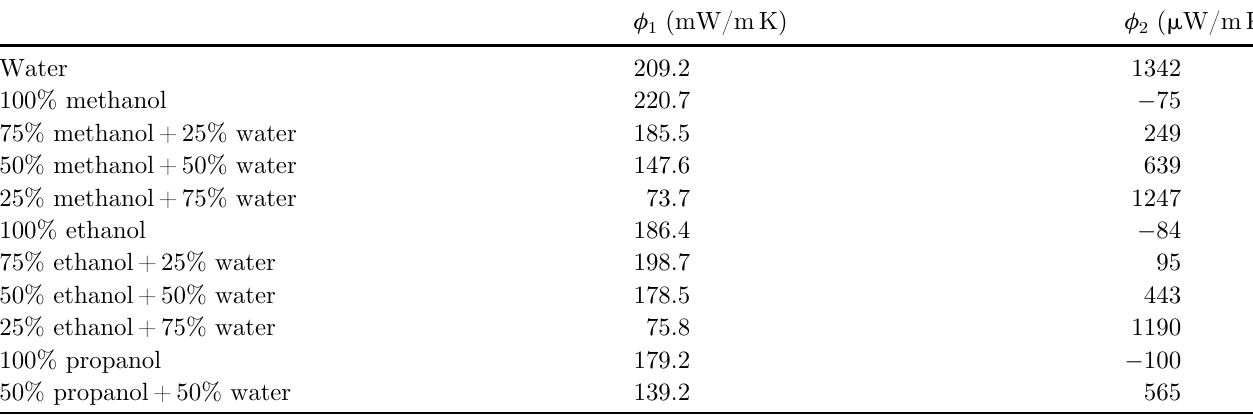
Table 2. Coef fi cients f of the equation of Assael et al.